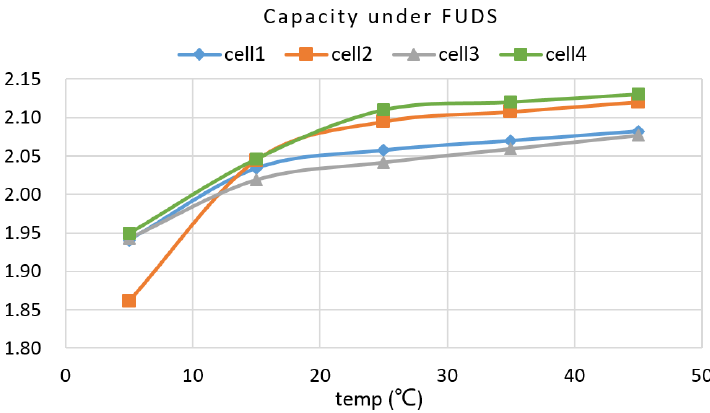
Figure 7. The measured capacity of four 18650 cells under five temperatures (5 ◦ C,15 ◦ C, 25 ◦ C, 35 ◦ C, and 45 ◦ C).